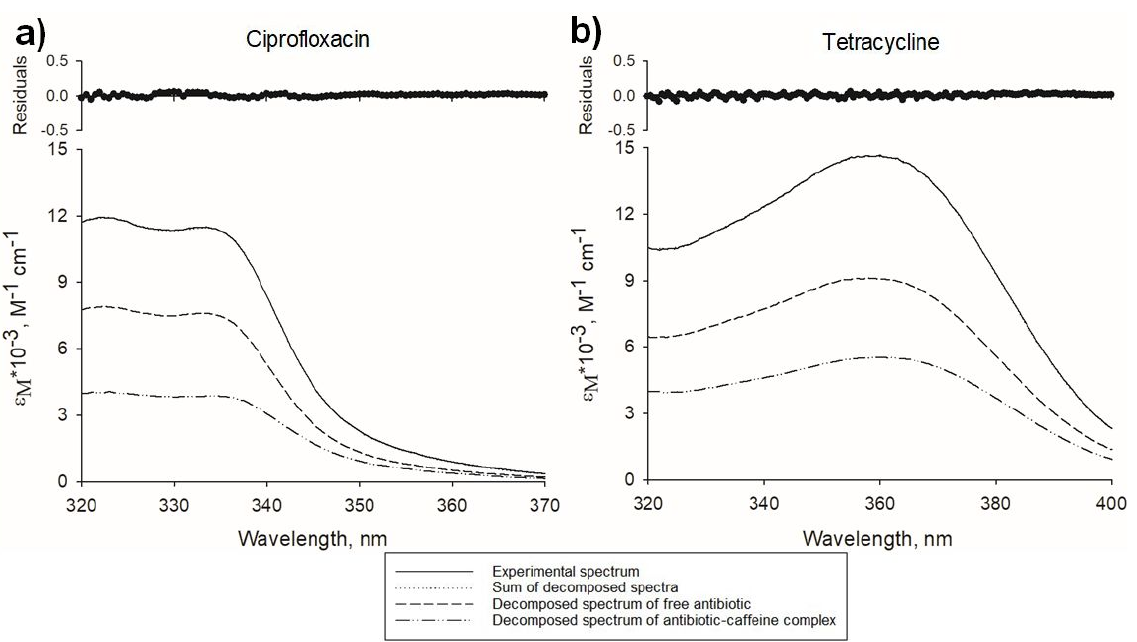
Figure 2. Examples of two-component decomposition of antibiotic-caffeine mixture spectra. ( a ), decomposition of mixture spectrum containing ciprofloxacin (55.1 µM) and caffeine (10.6 mM), molar fraction of free ciprofloxacin = 0.64; ( b ), decomposition of mixture spectrum containing tetracycline (40.4 µM) and caffeine (7.78 mM), molar fraction of free tetracycline = 0.61. Solid lines represent experimental spectra, dotted lines—sum of calculated decomposed spectra, dashed lines—calculated spectra of free antibiotics, dashed-dotted lines—calculated spectra of antibiotics complexed with caffeine. Top panels show residuals of experimental and the sum of calculated decomposed spectra .